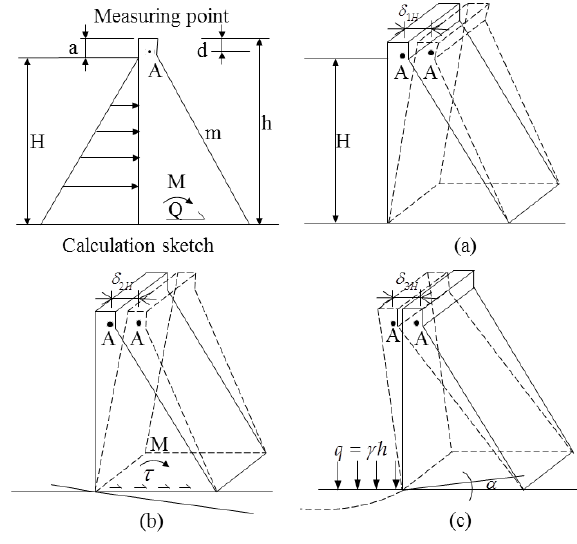
Figure 1. Three components of δ H : ( a ) δ 1 H ; ( b ) δ 2 H ; ( c ) δ 3 H